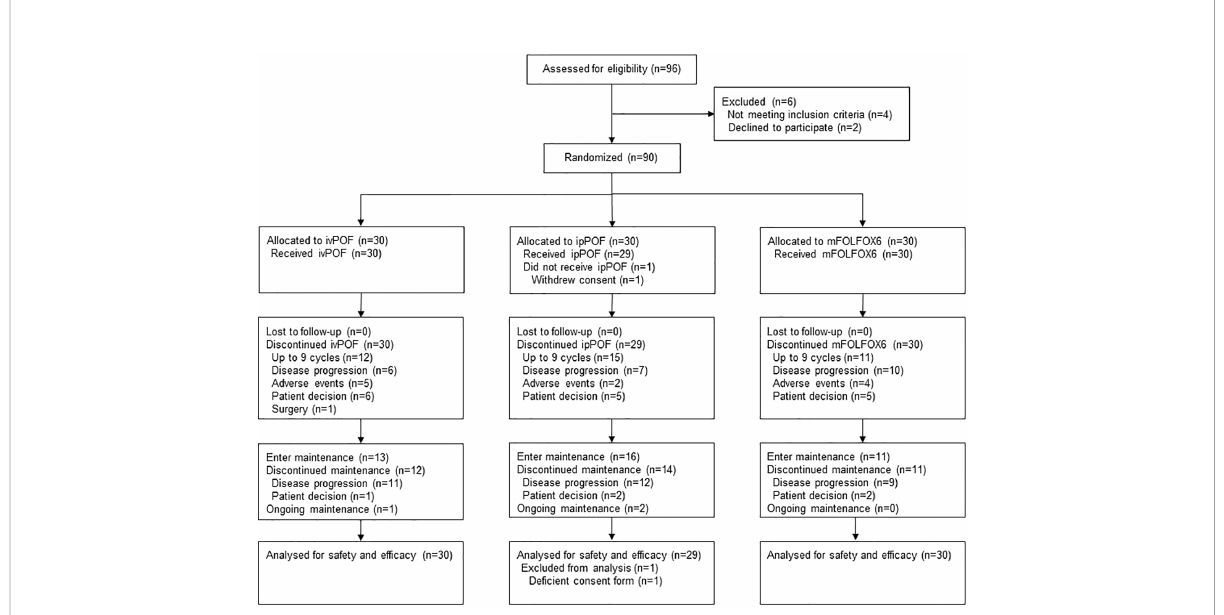
FIGURE 1 Trial pro fi le. ivPOF, intravenous paclitaxel, oxaliplatin, fl uorouracil, and leucovorin; ipPOF, intraperitoneal paclitaxel, oxaliplatin, fl uorouracil, and leucovorin; mFOLFOX6, modi fi ed oxaliplatin, fl uorouracil, and